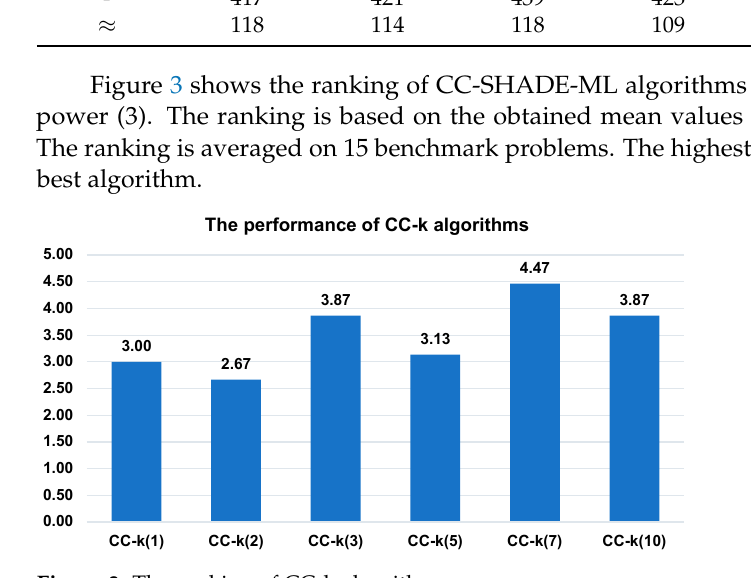
Table 3. The results of the Wilcoxon test for CC-k with different parameter